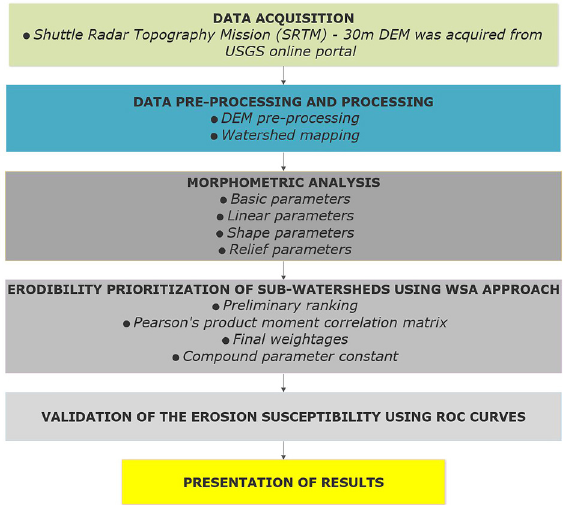
Fig. 2: Methodology